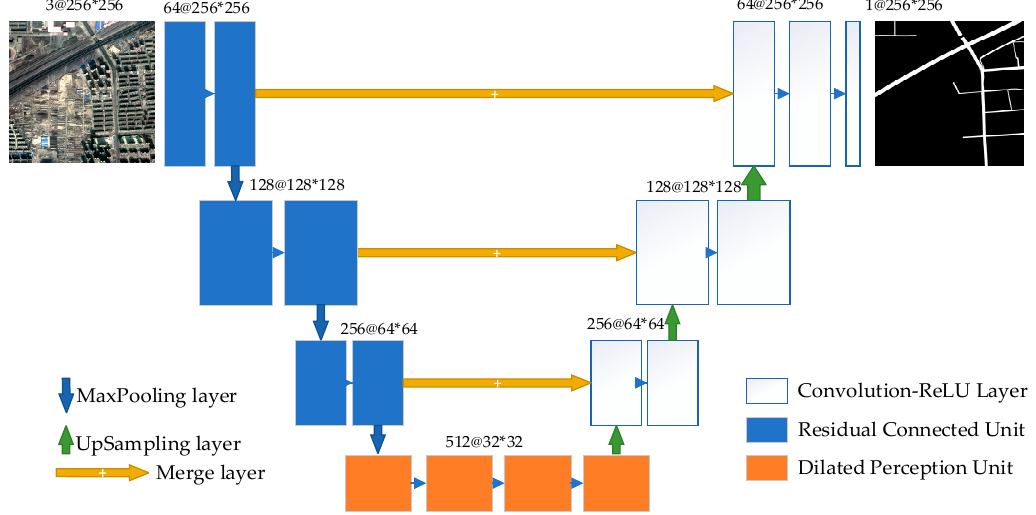
Figure 1. Illustration of the refined deep residual convolutional neural network (RDRCNN). Figure 2. Illustration of the refined deep residual convolutional neural network